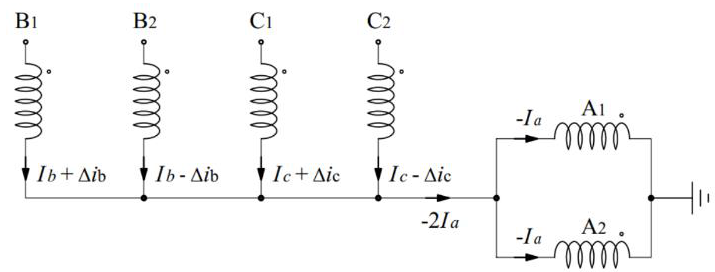
Figure 2. Connection of the coils for two-phase position